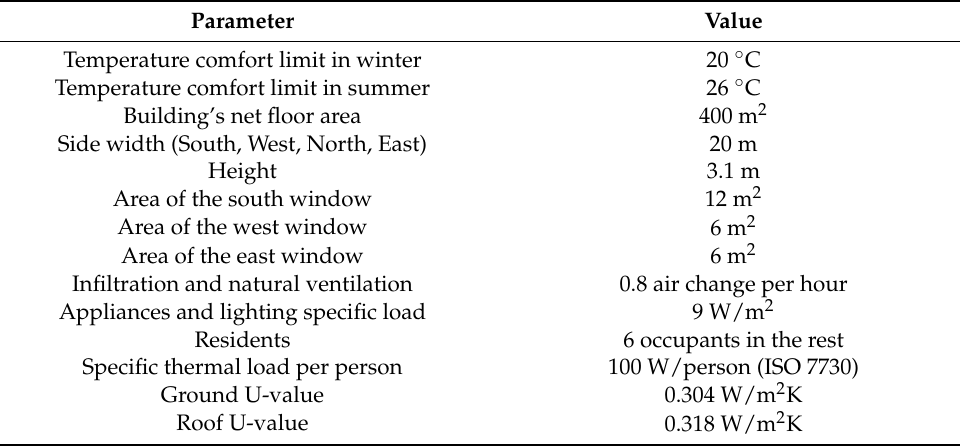
Table 1. Basic data for the building